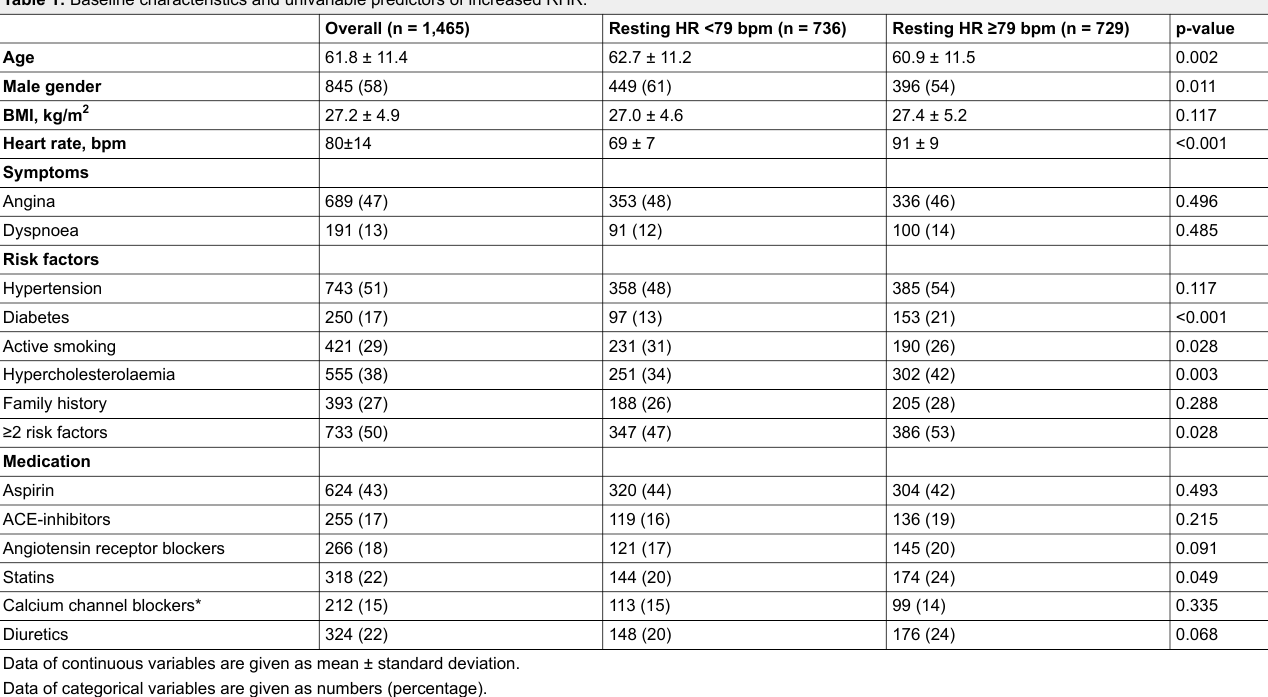
Table 1: Baseline characteristics and univariable predictors of increased RHR.